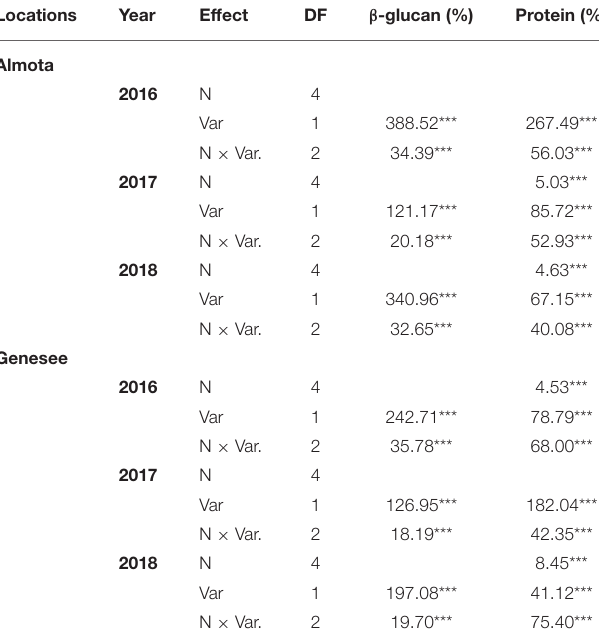
TABLE 1 | Analysis of Variance with F value for β -glucan and protein for food barley grown under five nitroge N treatments on no-till farms of Almota and Genesee.